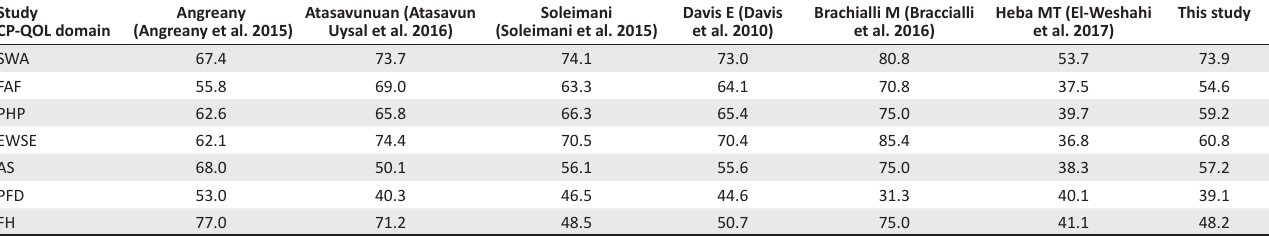
TABLE 7: Comparative tables of the means found in the literature in each of the domains of the cerebral palsy quality of life-child. Study Angreany Atasavunuan (Atasavun CP-QOL domain (Angreany et al. 2015) Uysal et al.